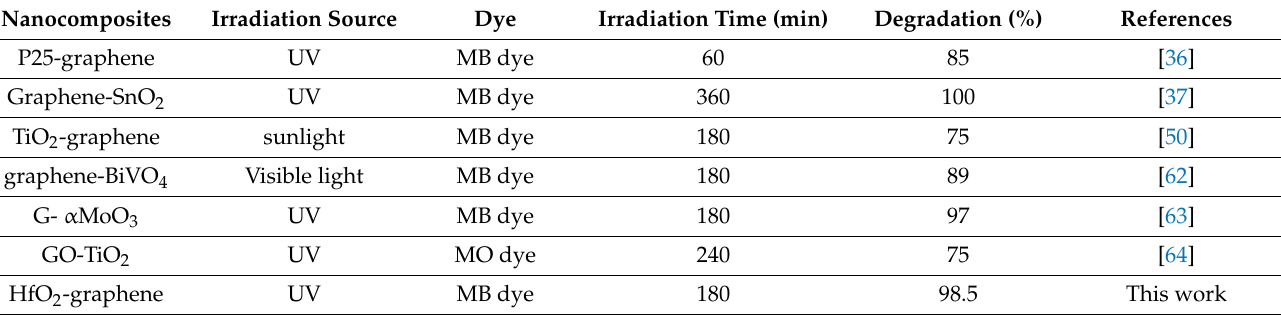
Table 1. Comparison of photocatalytic MB dye degradation efficiency of HfO 2